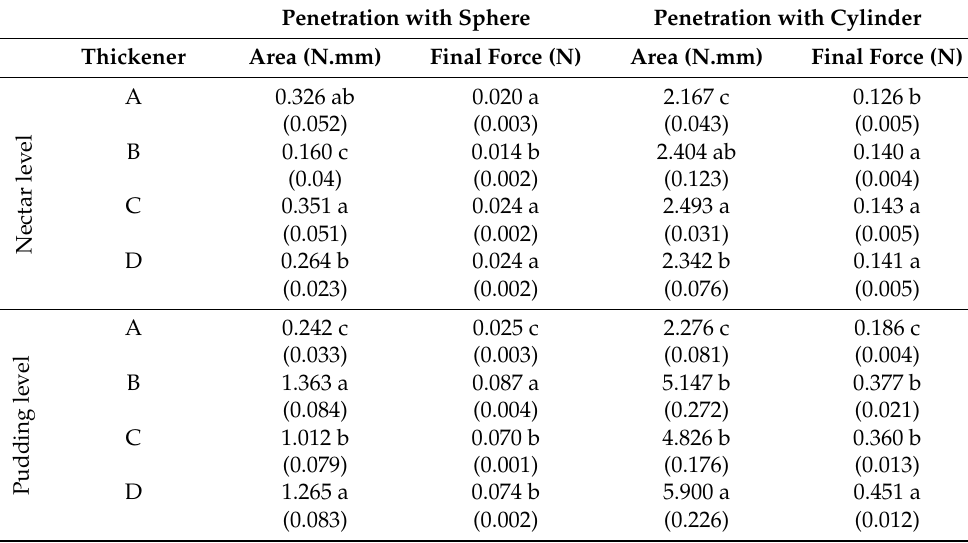
Means values in the same column with different letters for each consistency level are significantly different ( p ≤ 0.05) according to Fisher’s least significant difference. For each mean, standard deviation is in